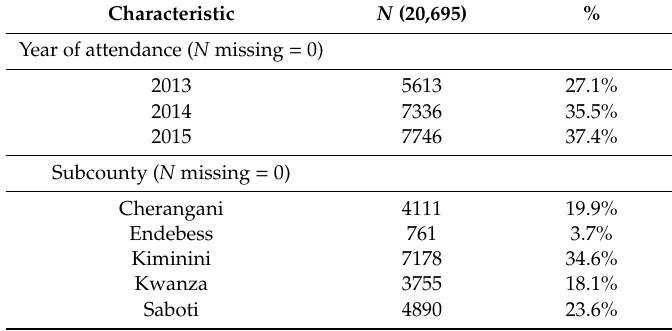
Table 1. Characteristics of Patients attending Kitale eye unit between 2013 to 2015 ( N = 20,695)